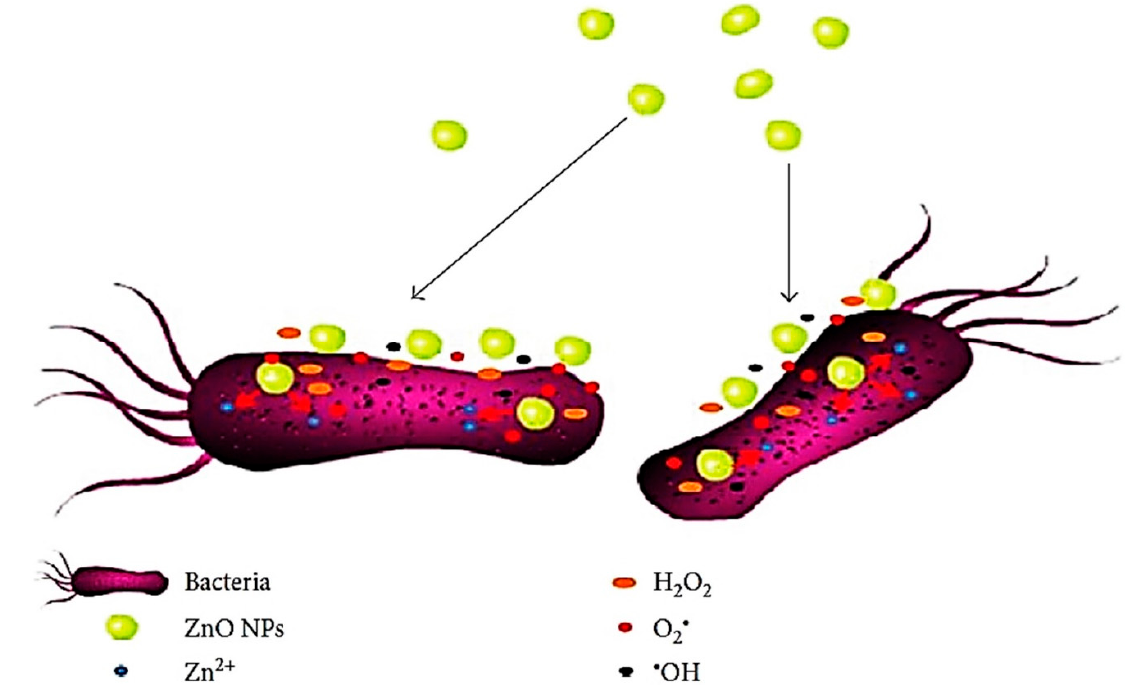
Figure 5. Graphical representation of antimicrobial activity of nZnO. Reprinted with permission from Reference [58]. Copyright 2018, with permission from Hindawi.